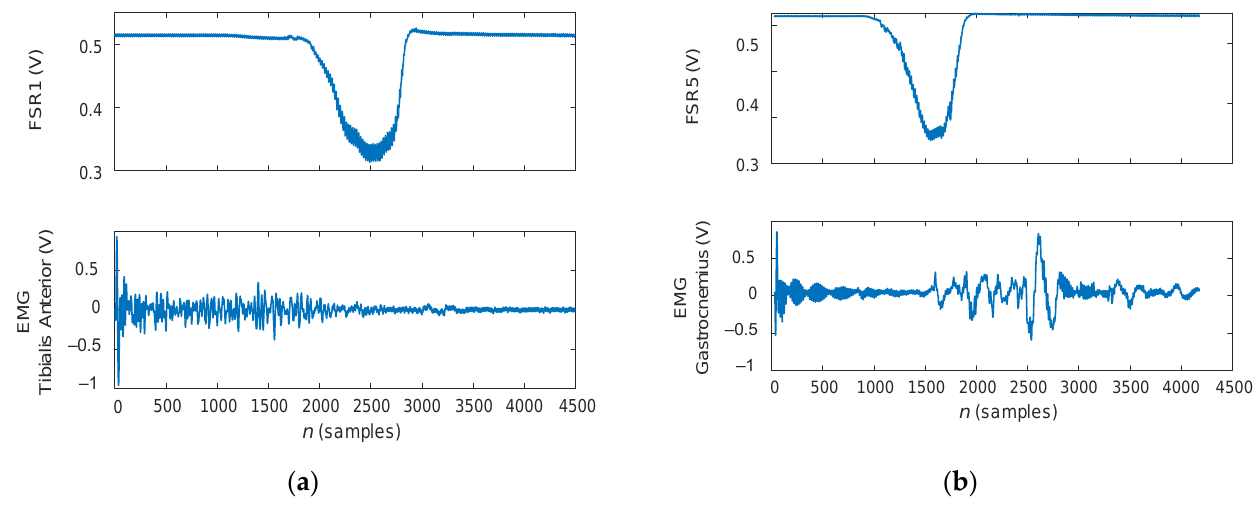
Figure 15. Time-domain plots of the FSR and EMG signals lack of interdependency during the gait phases: ( a ) FSR 1 and tibialis anterior at heel strike, ( b ) FSR 5 and gastrocnemius at toe-off.